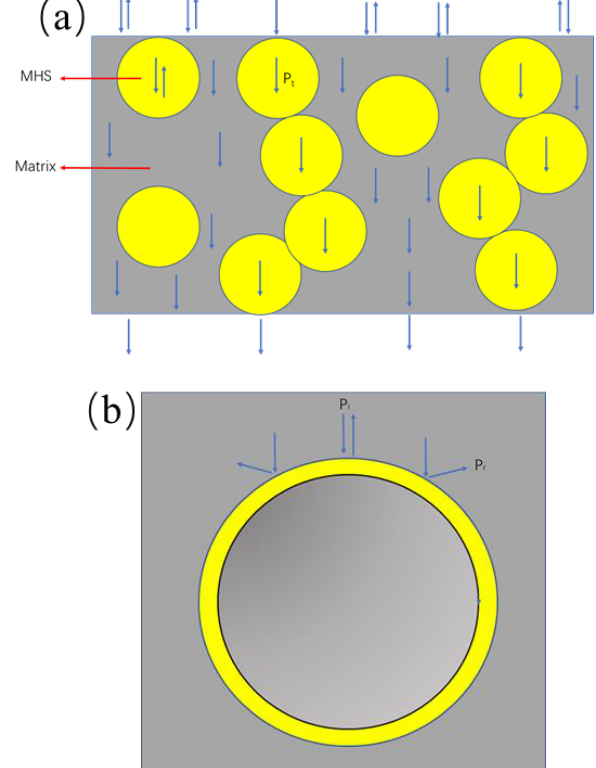
Figure 12. The schematic diagram of the sound wave propagation under the resonance condition: ( a ) in the MHSC; ( b ) on the MHS. condition: ( a ) in the MHSC; ( b ) on the